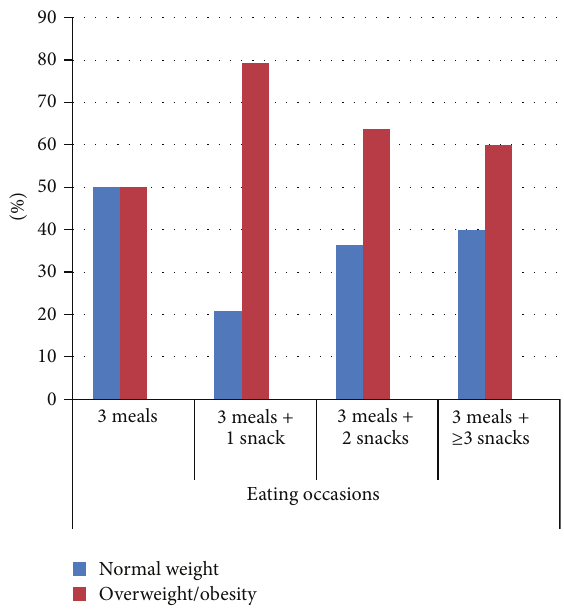
Figure 1: Daily percentage of energy distribution for breakfast, lunch, dinner, and snacks. Figure 2: Comparison of eating occasions and nutritional status of male participants.